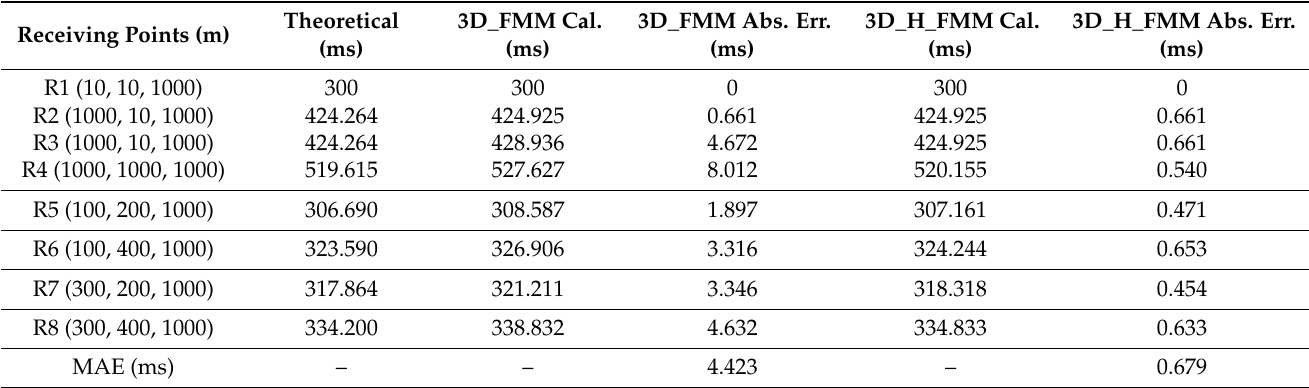
Table 5. The travel time and its absolute error at the receiving points of R1 to R8 calculated by 3D_H_FMM and 3D_FMM in the Case B: large-scaled homogeneous model.